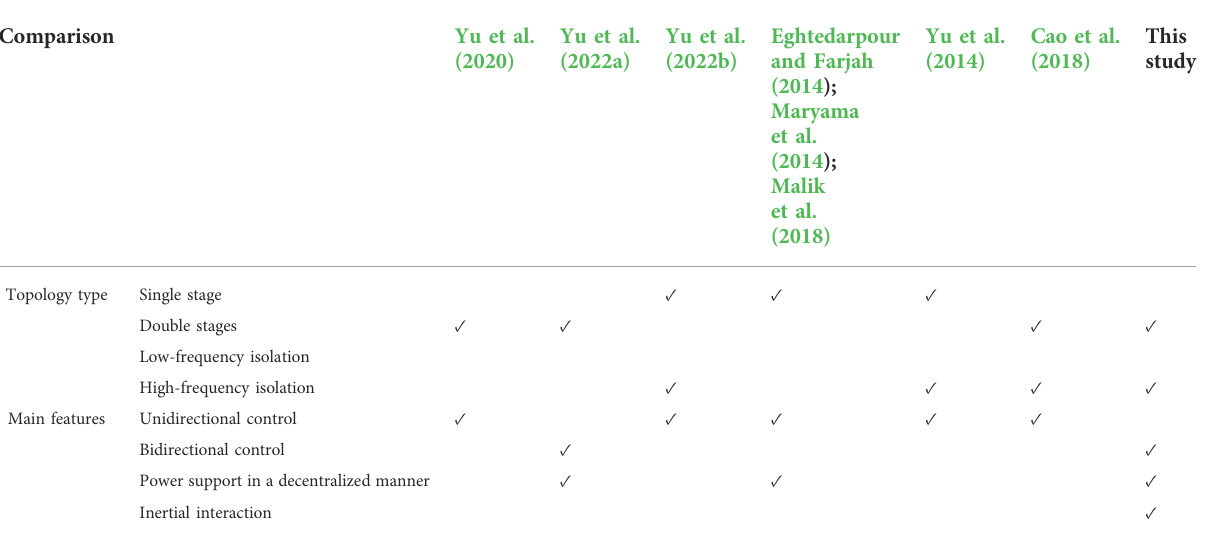
TABLE 1 Comparison with control